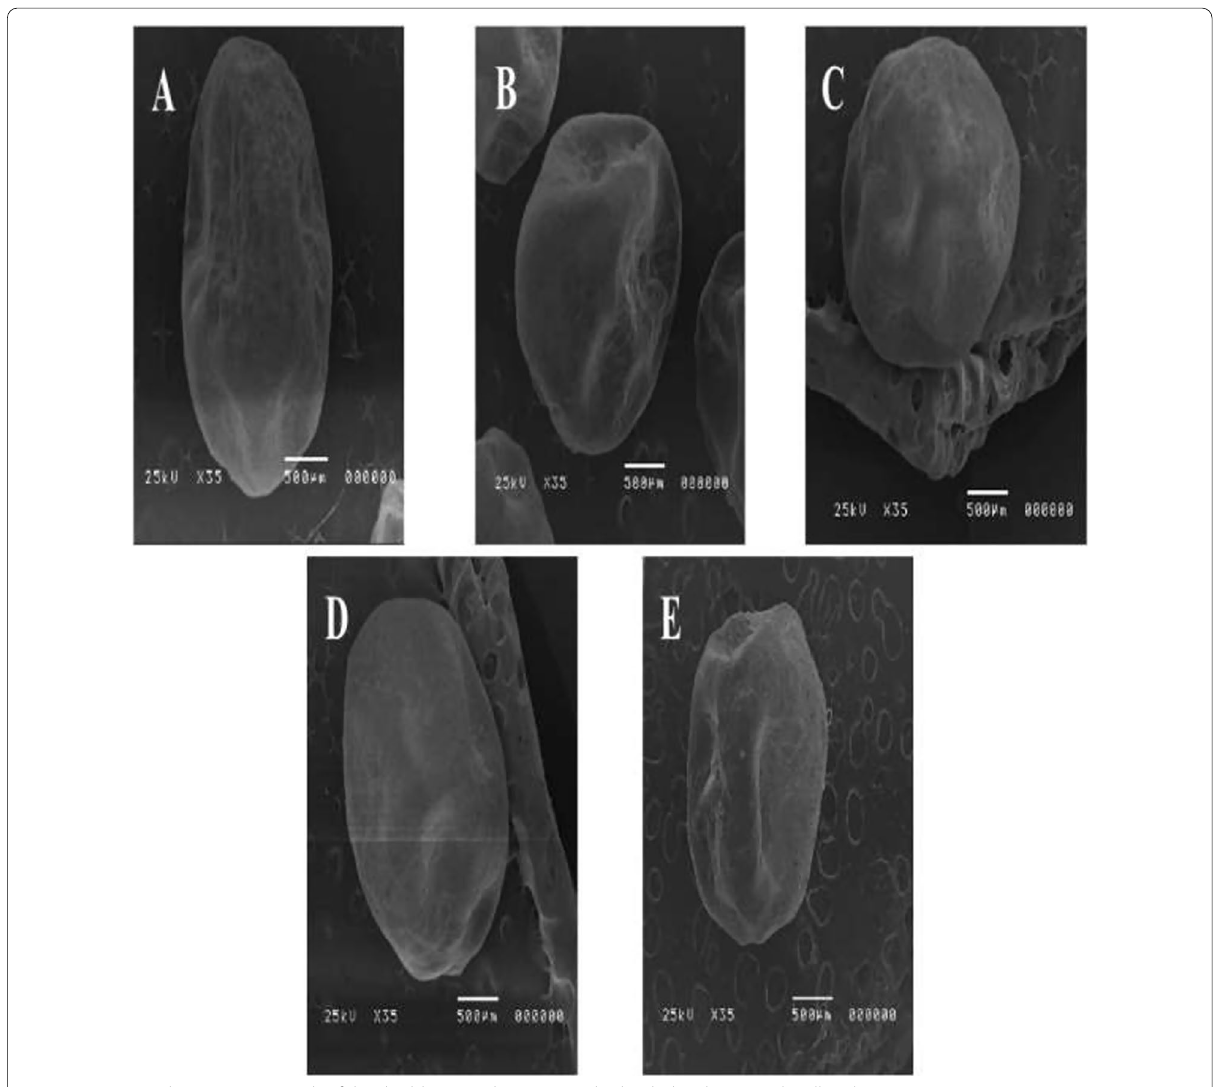
Fig. 2 Scanning electron micrograph of the double-coated microcapsules loaded with A Lactobacillus plantarum MK780211, B L. plantarum MK780215, C L. kunkeei MK780216, D L. kunkeei MK780218 and E Lactobacillus sp .